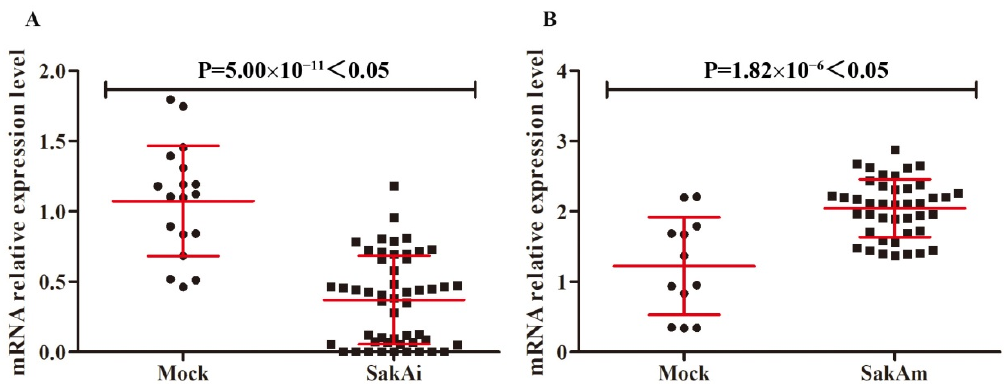
Figure 4. qRT–PCR analysis of the expression level of chitinase CcChiE1 in CcSakA gene silencing (SakAi) transformants ( A ) and CcSakA phosphomimicking mutant (SakAm) transformants ( B ) compared with mock transformants. A β -tubulin gene was used to standardize the mRNA level. Four mock transformants (circle), eight SakAi transformants (square in ( A )), and eight SakAm transformants (square in ( B )) were analyzed with at least three repeats of each transformant. Data are presented as the mean and standard error. Tests for significance were performed by a t-test in Microsoft Excel 2010.